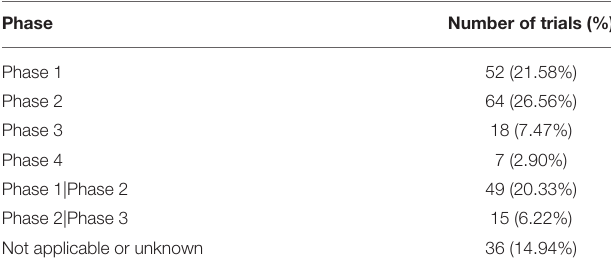
TABLE 2 | Trial start dates.